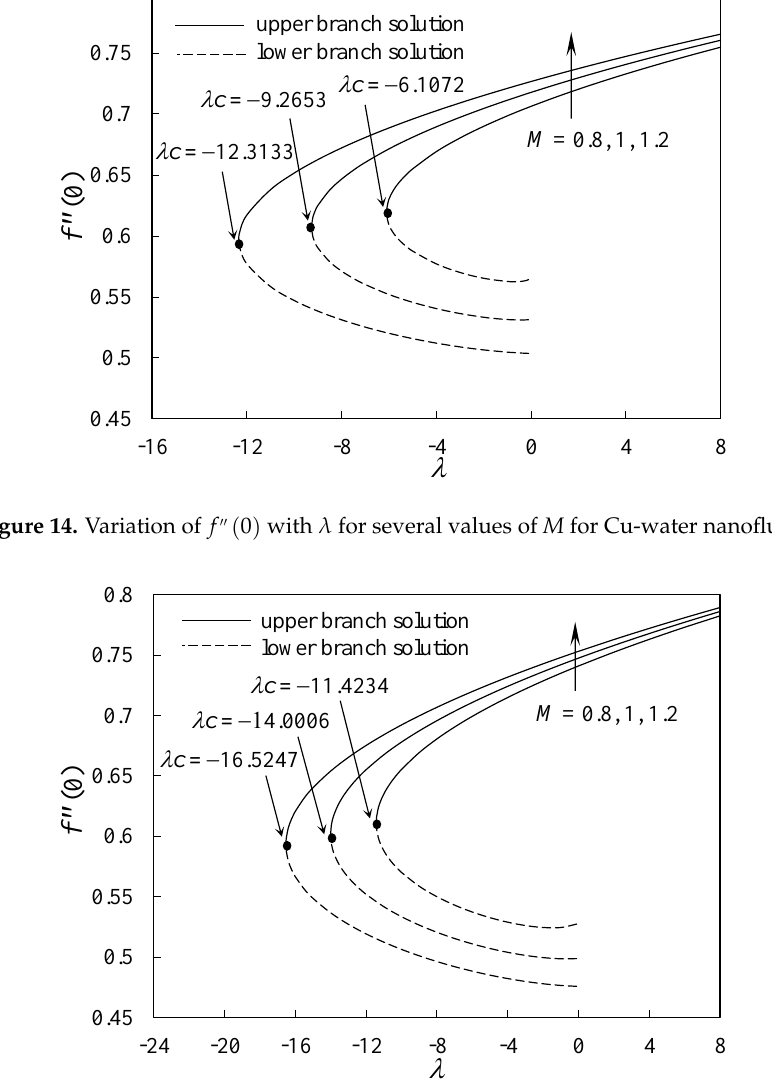
Figure 15. Variation of